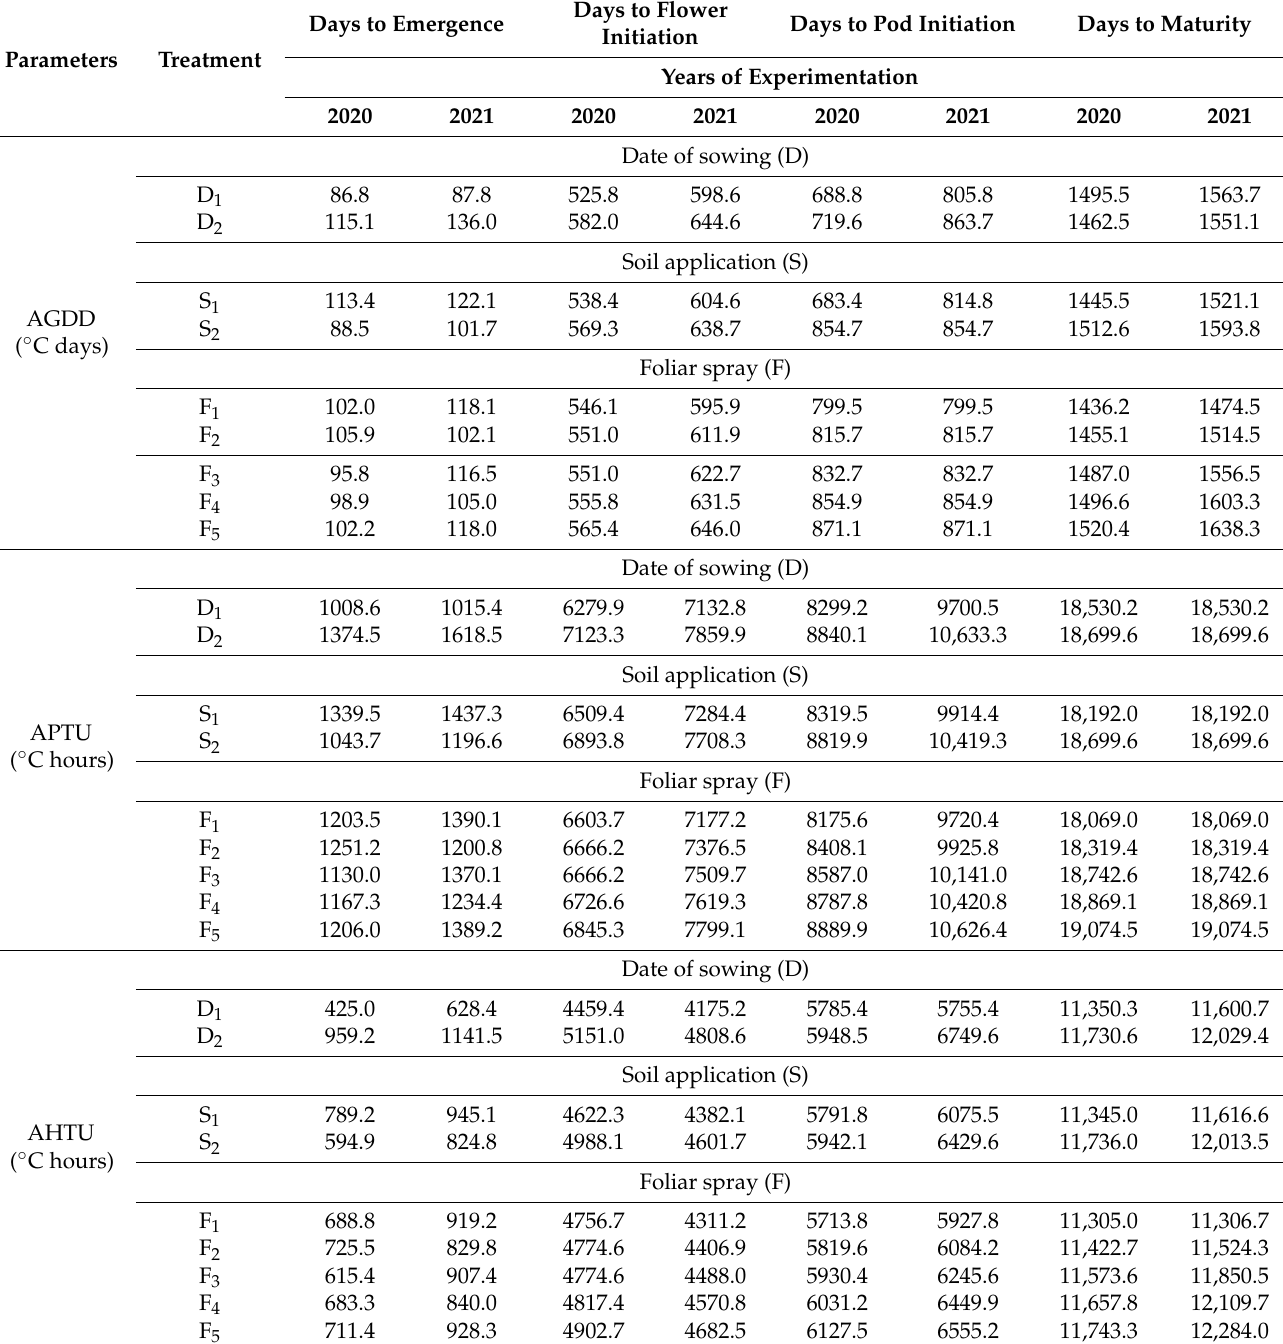
Table 8. Factor-wise requirements of accumulated GDD, PTU, and HTU of black gram at different phenophases.